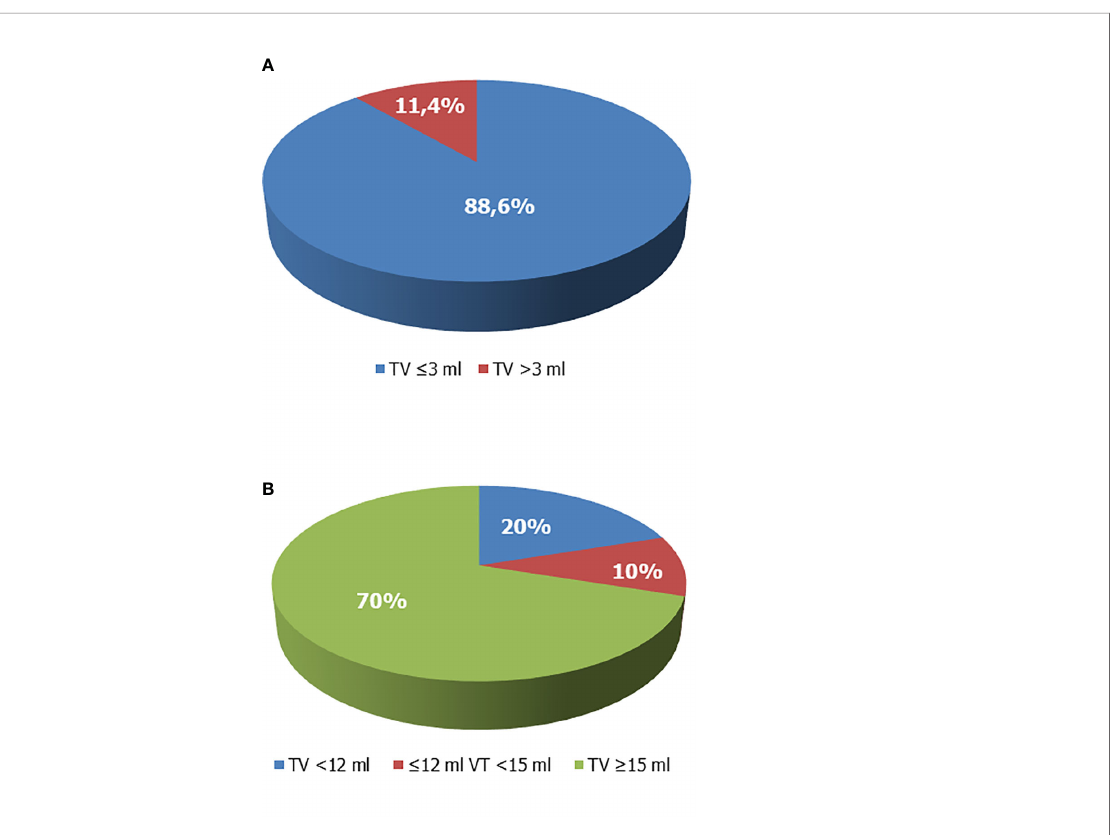
FIGURE 3 | Testicular volume (TV) of boys with growth hormone (GH) de fi ciency. (A) TV at enrollment. Overall, 88.6% of patients whose TV values were available prior to recombinant human GH (rhGH) administration and aged ≥ 10 years showed TV values ≤ 3 ml and had a Tanner stage 1. (B) TV at the end of rhGH administration. The 70% of patients on rhGH therapy had TV ≥ 15 ml at the end of therapy, 20% had values <12 ml, compatible with testicular hypotrophy. Ten percent had borderline values (12 ml ≤ TV < 15